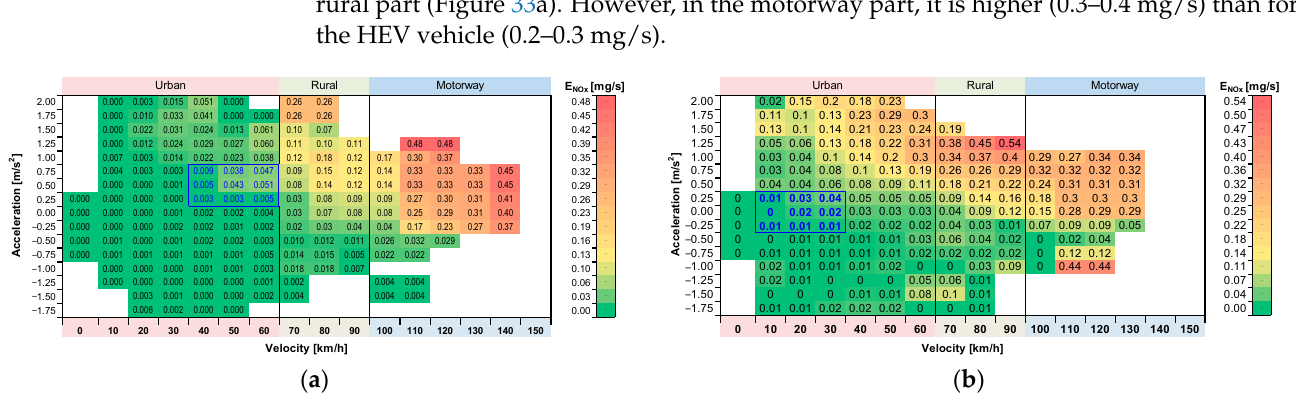
Figure 33. Emission rate of nitrogen oxides (E NOx ) in the RDE test for: ( a ) plug-in; ( b ) HEV. The analysis on particle number rate shows similarity. For the plug-in vehicle (Figure